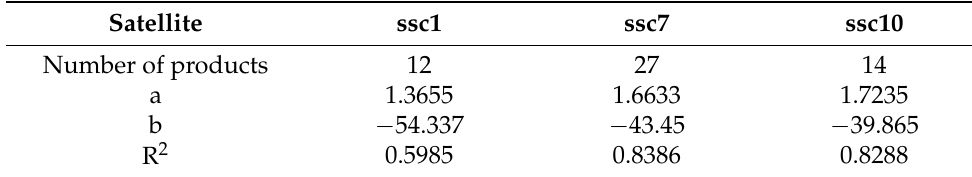
Figure 10. The mean SNR values obtained from three SkySat satellites (ssc1, ssc7, ssc10) as a function of in-band radiance and linear representation. Table 4. The SNR and in-band radiance linear model estimate: slope (a), offset (b), and coefficients of determination.